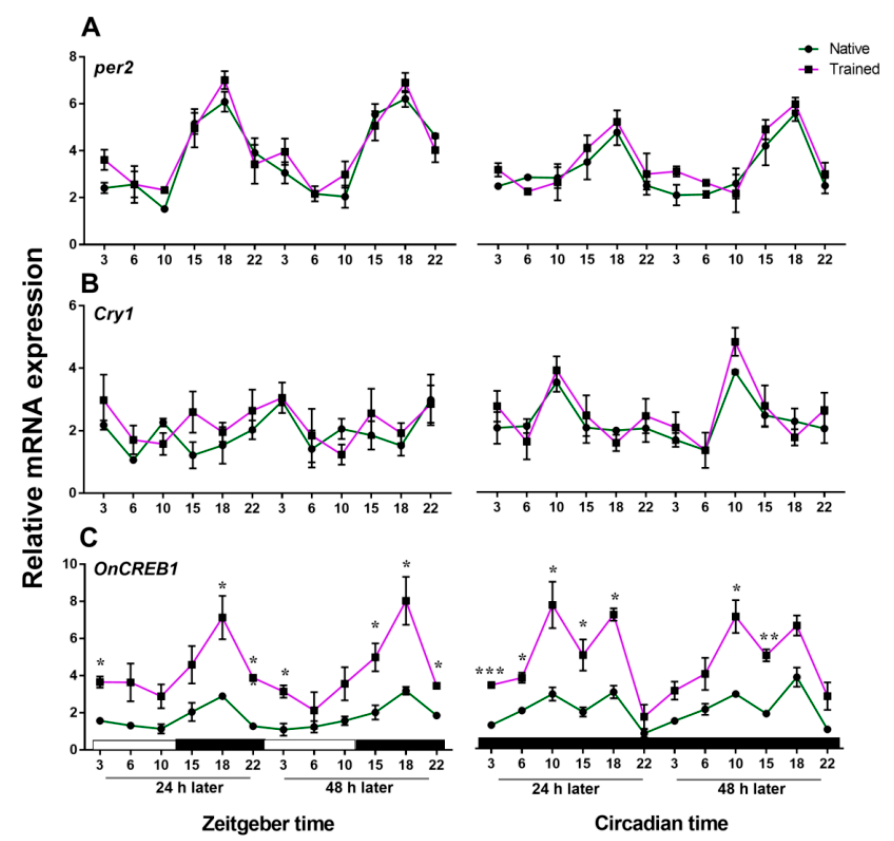
Figure 6. The expression comparison of related genes between native and trained group under LD and DD cycle. ( A ) Expression comparison of per2 . Quantitative analysis of per2 revealed that there was not significantly di ff erent between native and trained animals, and no interaction between both factors (sampling time × training condition) were detected (LD, p > 0.05; DD, p > 0.05). ( B ) Expression comparison of cry1 . There was no significant e ff ect of sampling time × training condition on cry1 (LD, p > 0.05; DD, p > 0.05). ( C ) Expression comparison of OnCREB1 . There was a significant e ff ect of sampling time × training condition on OnCREB1 expression (LD, p = 0.013; DD, p < 0.01). The training increased the OnCREB1 expression, but not significant at all time points. * indicates p < 0.05; ** indicates p < 0.01; *** indicates p < 0.001. Statistical analyses of all data were performed using two-way analysis of variance (ANOVA) with Bonferroni post hoc analysis for comparisons between groups. Error bars in the figure represent SEM ( n = 3 for every time point in each group).